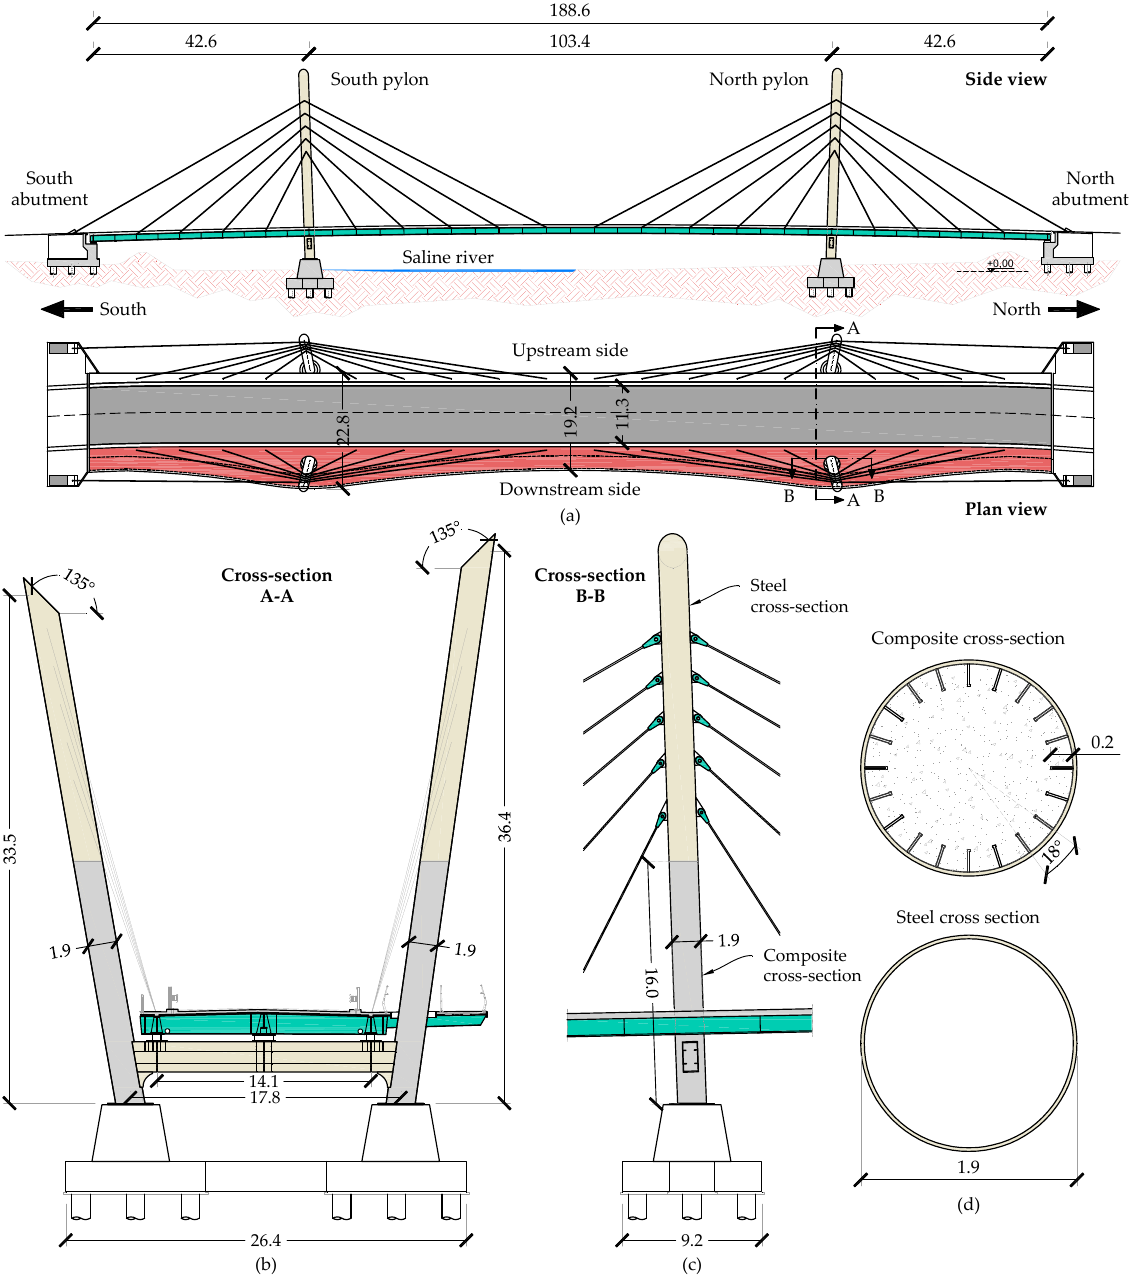
Figure 2. Schemes and characteristics of the bridge (measures are in meters): ( a ) side and plan schemes, ( b ) cross-section A-A, ( c ) cross-section B-B, and ( d ) detail of the pylon